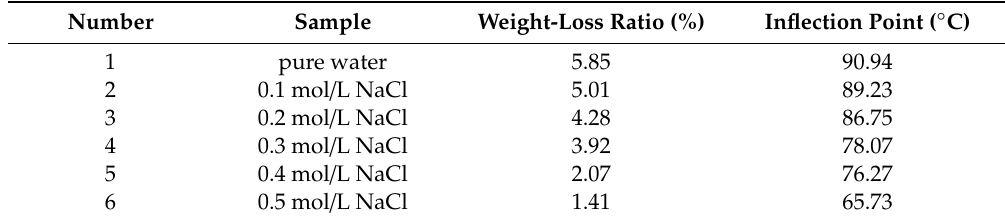
Table 1. Weight-loss ratios and inflection points of montmorillonite samples.